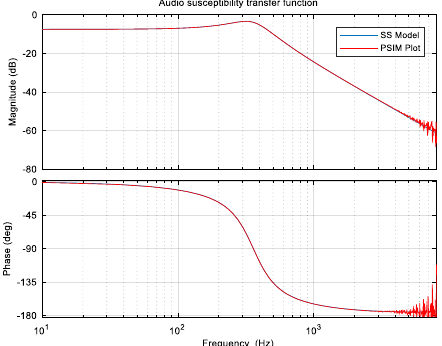
Figure 15. Audio − susceptibility transfer function for a buck − boost converter.